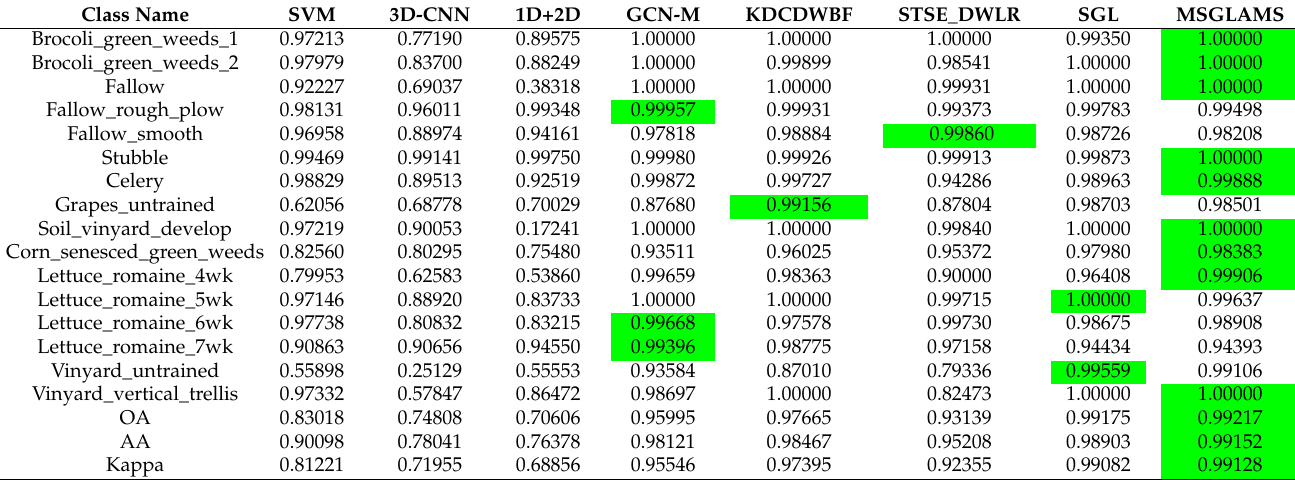
Table 6. Classification accuracy for the Salinas image with ten labeled samples per class.